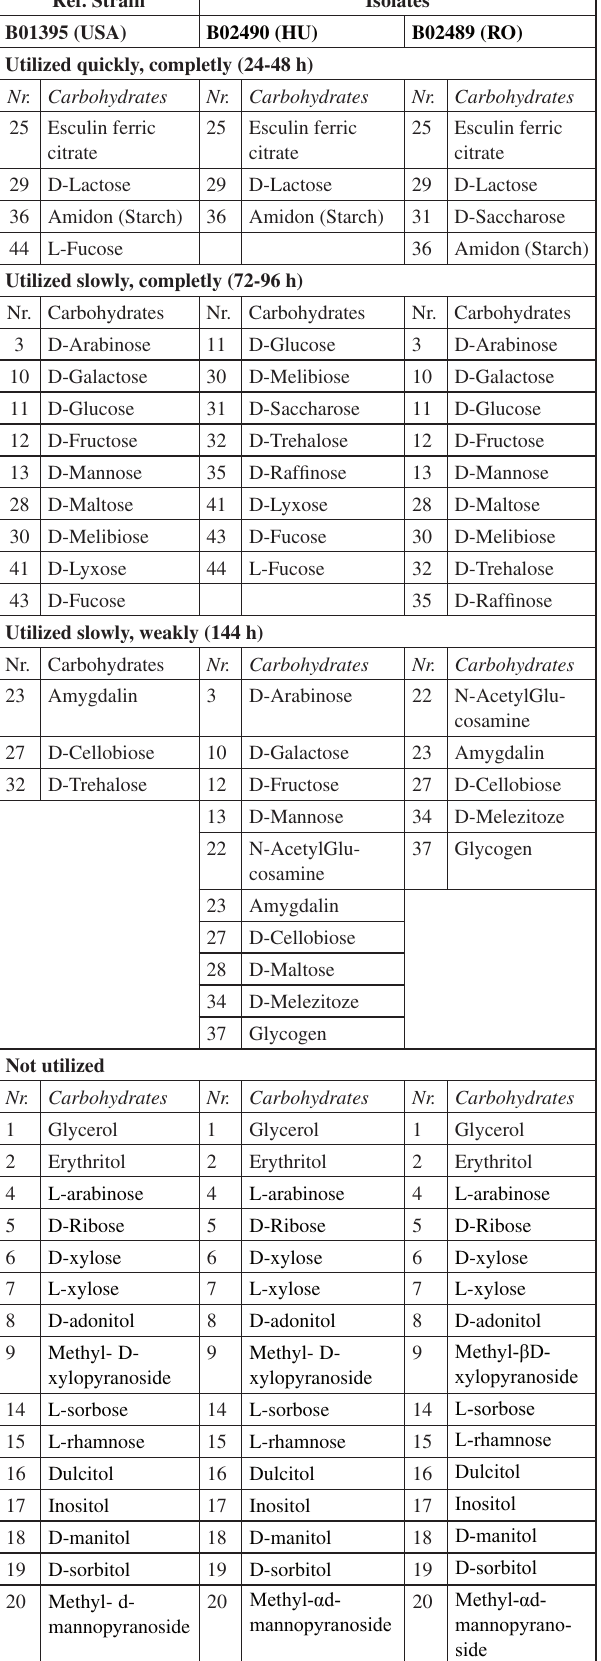
Table 2. Carbohydrates utilized by Xaj isolates using API 50CH system Ref.